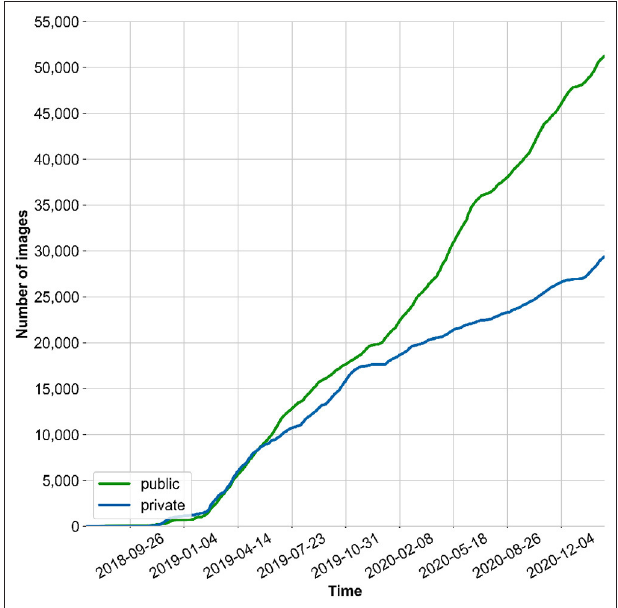
FIGURE 1 | Cumulative number of images collected via the MyFoodRepo App (including classes not considered in this